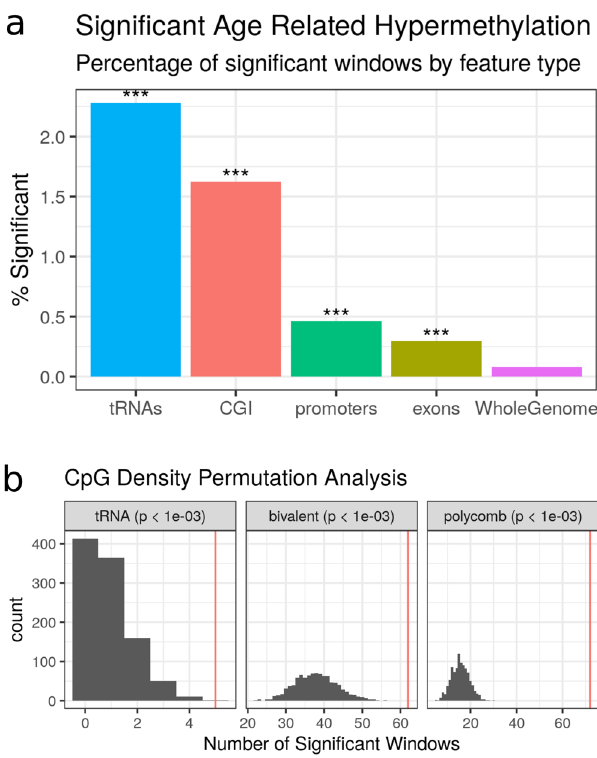
Fig. 2 Age-related hypermethylation is enriched in tRNA genes relative to genomic background and accounting for CpG density. a tRNA genes are enriched for age-related hypermethylation compared to the genomic background, Fisher ’ s exact test ( p < 1.05 × 10 − 27 , one-sided). All Fisher ’ s exact test results are included in Supplementary data 2 (CGI: CpG islands). b tRNA genes show more signi fi cant hypermethylated loci than CpG density-matched permutations. Each permutation represented a random set of windows matching the CpG density of the functional unit (tRNA gene loci, bivalent domains, and polycomb group target promoters). These are subsequently assessed for signi fi cant age-related DNAm changes, quoted p values are empirical p values based on the permutation results. The red line is the observed number of signi fi cant loci. Source data are provided as a Source Data fi